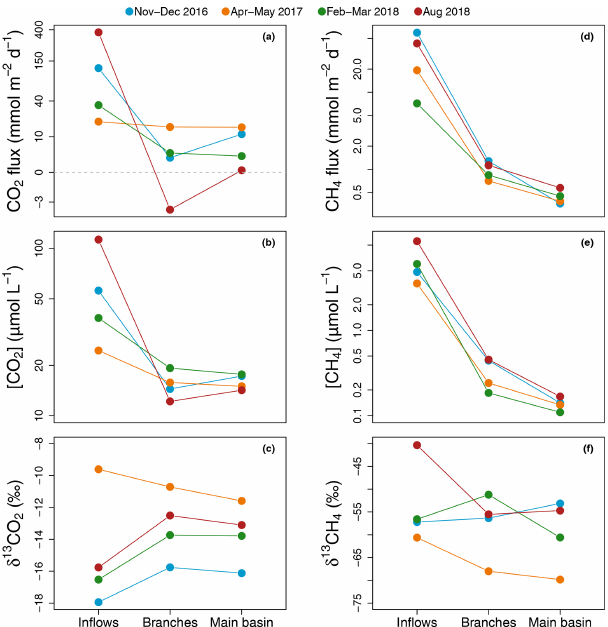
Figure 2. Average of spatially interpolated surface CO 2 (a–c) and CH 4 (d–f) fluxes (a, d) , concentrations (b, e) , and isotopic signa- tures (c, f) along the hydrological continuum from the reservoir in- flows to the main basin for each sampling